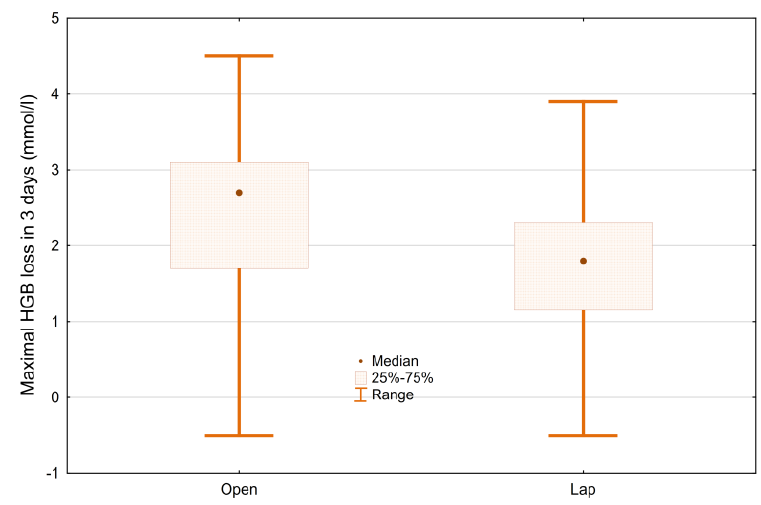
Figure 5. Maximal loss of HGB in 3 days after the surgery ORC vs. LRC.